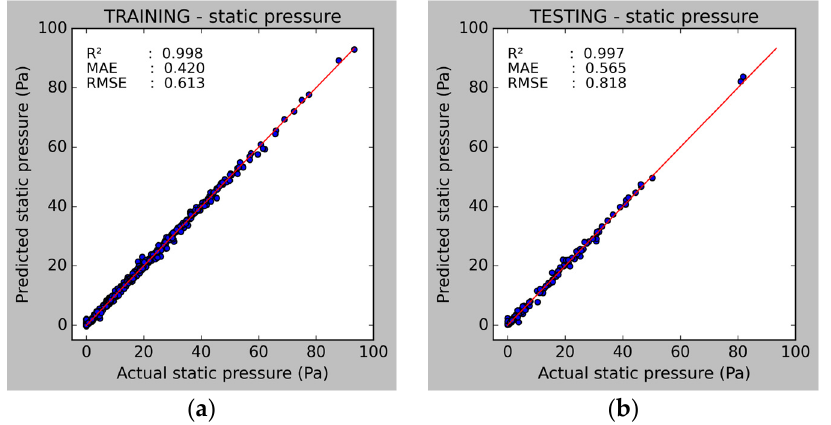
Figure 8. Scatterplot of the flowrate prediction model using ( a ) training data and ( b ) testing data. Table 6. Performance evaluation of flowrate and static pressure models.